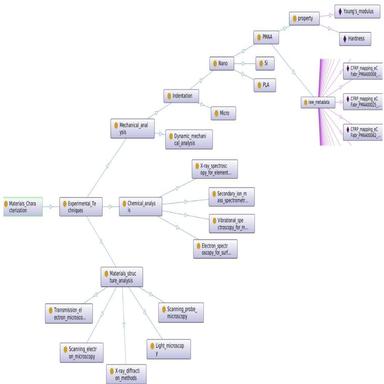
Ontology indicative example diagram for materials characterization methods.